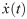
Vector representation of the excitation F(x, t) and the velocity of the response x˙(t).